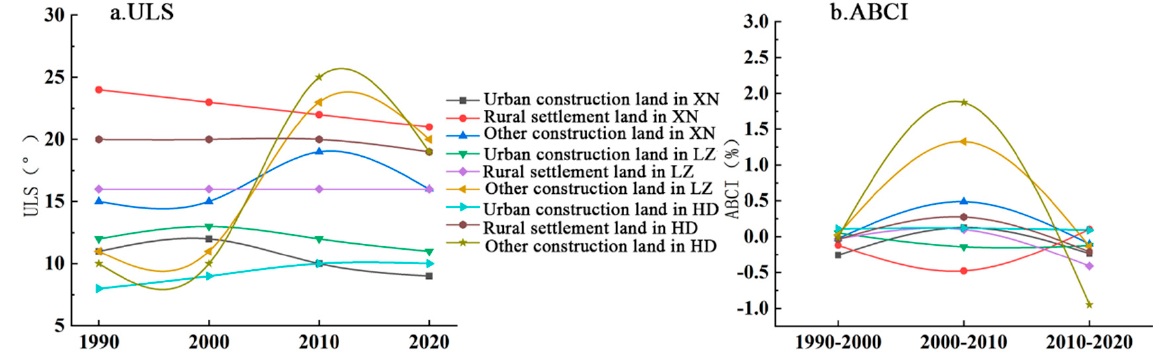
Figure 14. ABCI and ULS values of typical cities in the LXUA from 1990 to 2020.